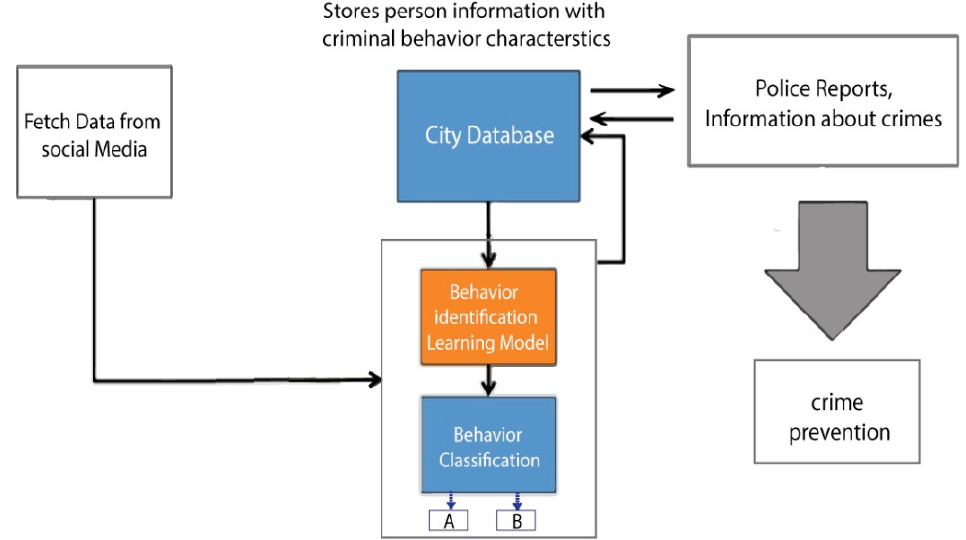
Figure 3. Framework of Criminal Behavior Detection.